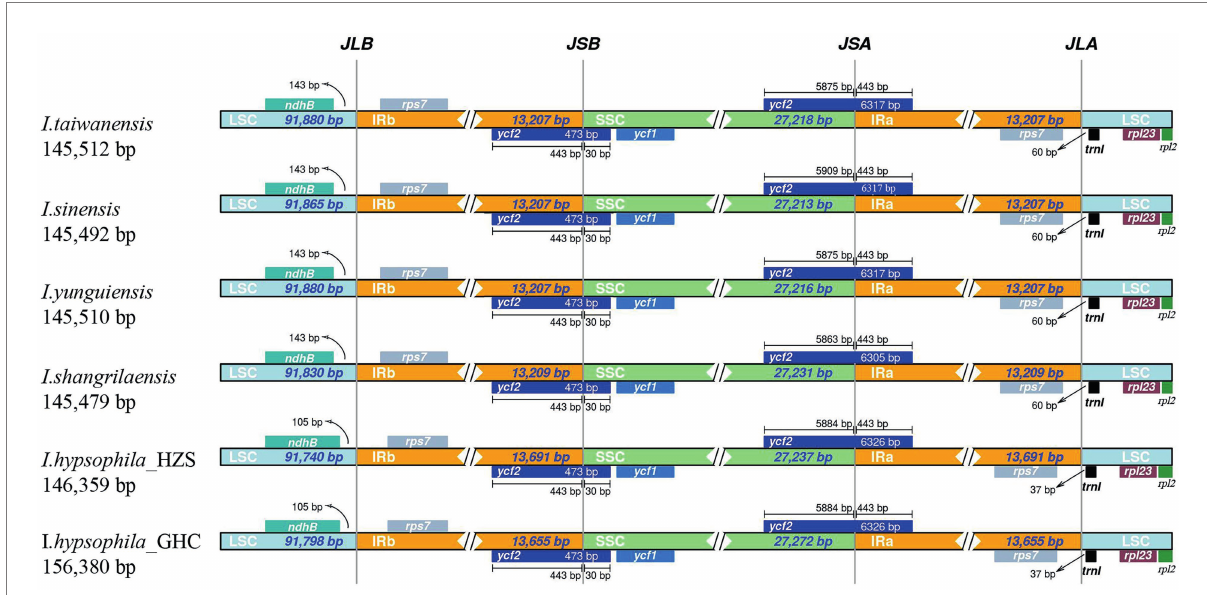
FIGURE 3 Global alignment of chloroplast genomes of six Isoetes , with the I. taiwanensis genome as the reference. Gray arrows indicate the direction of gene transcription. Red blocks indicate conserved non-coding sequences (CNS), and blue blocks indicate conserved genes. The y -axis represents the percent identity within